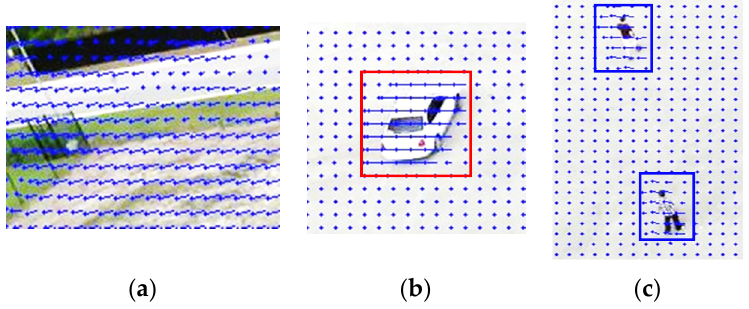
Figure 8. Result of motion vectors without image stabilization: ( a ) Background, ( b ) car, ( c ) people.